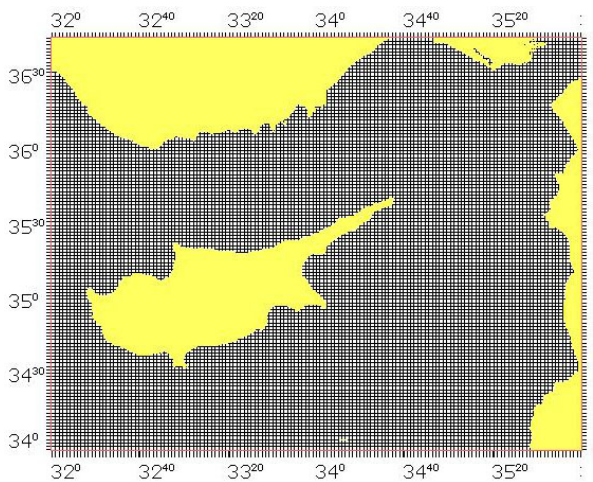
Fig. 4. CYCOM-Cyprus coastal ocean model domain with a hori- zontal resolution of 3 × 3km and 30 vertical layers from the surface down to